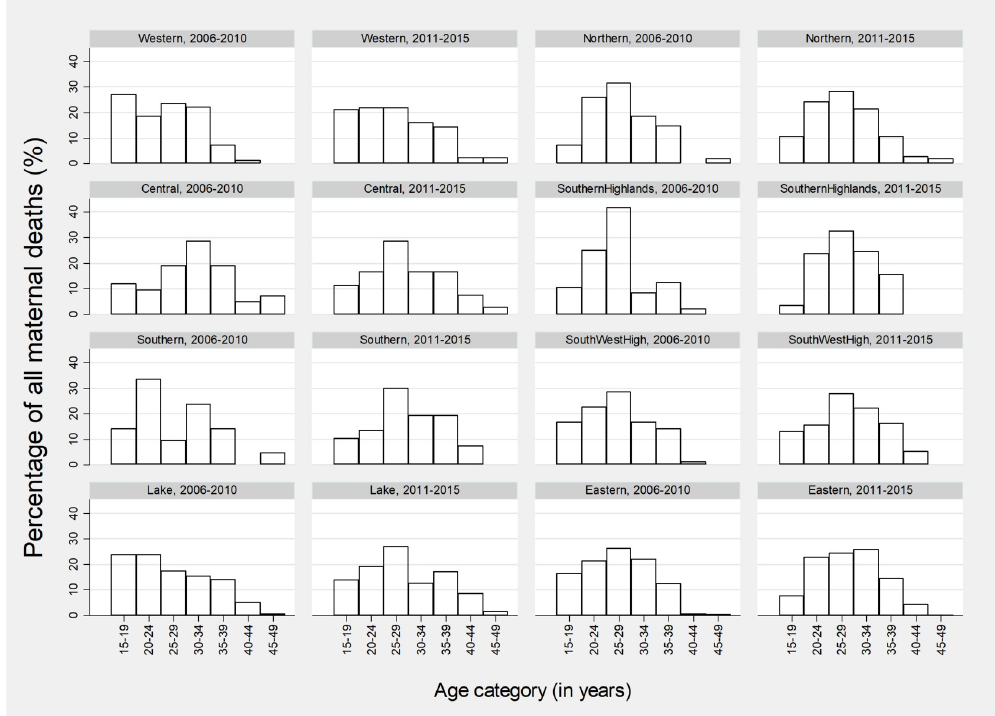
Fig 10. Percentage distribution for mortality patterns by age and geographical area comparing 2006–2010 and 2011– 2015 (n = 1,987).